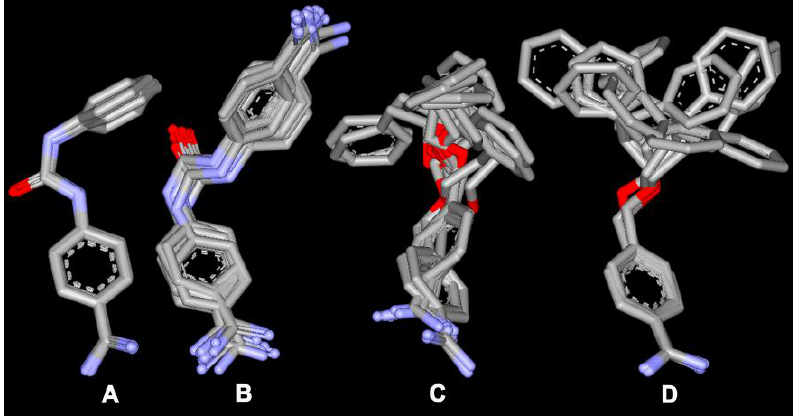
Figure 3. Top 10 docking solutions for inhibitors: ( A ) Bz1; ( B ) Bz4; ( C ) Bz6 and ( D )